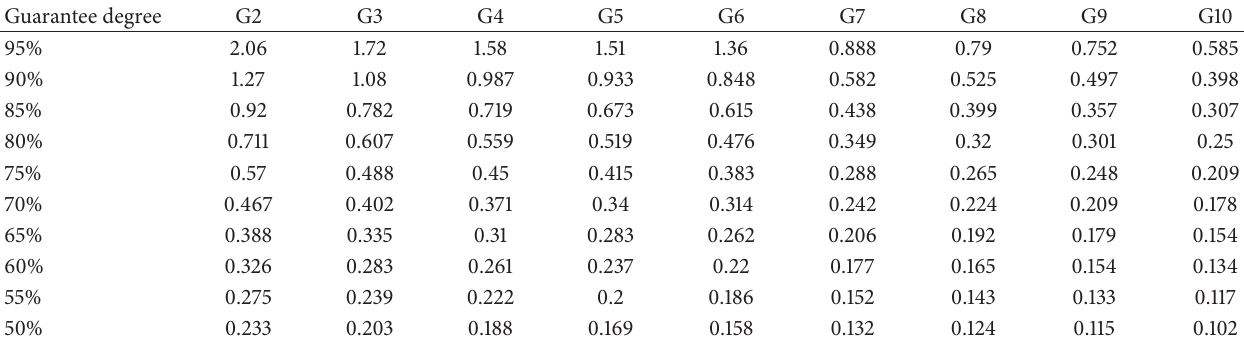
Table 2: Achievable error with different degrees of guarantee (populations composed of 25 individuals).